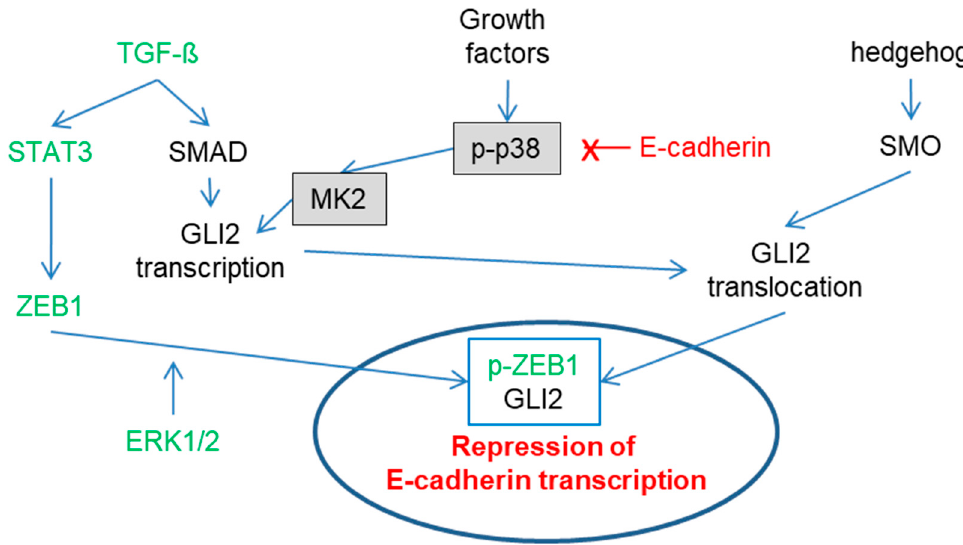
Figure 1. Complex regulation of E-cadherin expression. For ZEB1: STAT3 induces zinc finger E-box-binding homeobox 1 (ZEB1) transcription [47], and ZEB1 is then phosphorylated by ERK1/2 [48] followed by nuclear localization. For GLI2: TGF-ß via SMAD and p38 via MK2 induce GLI2 transcription [45,49,50]. Activation of SMO through the hedgehog pathway leads to GLI2 nuclear translocation [51,52]. Nuclear ZEB1 and GLI2 repress E-cadherin expression [53]. Interestingly, E-cadherin (*) expression reduces activation of the p38 signaling pathway [45], potentially via nuclear localization [54], thereby potentially counteracting its own downregulation.